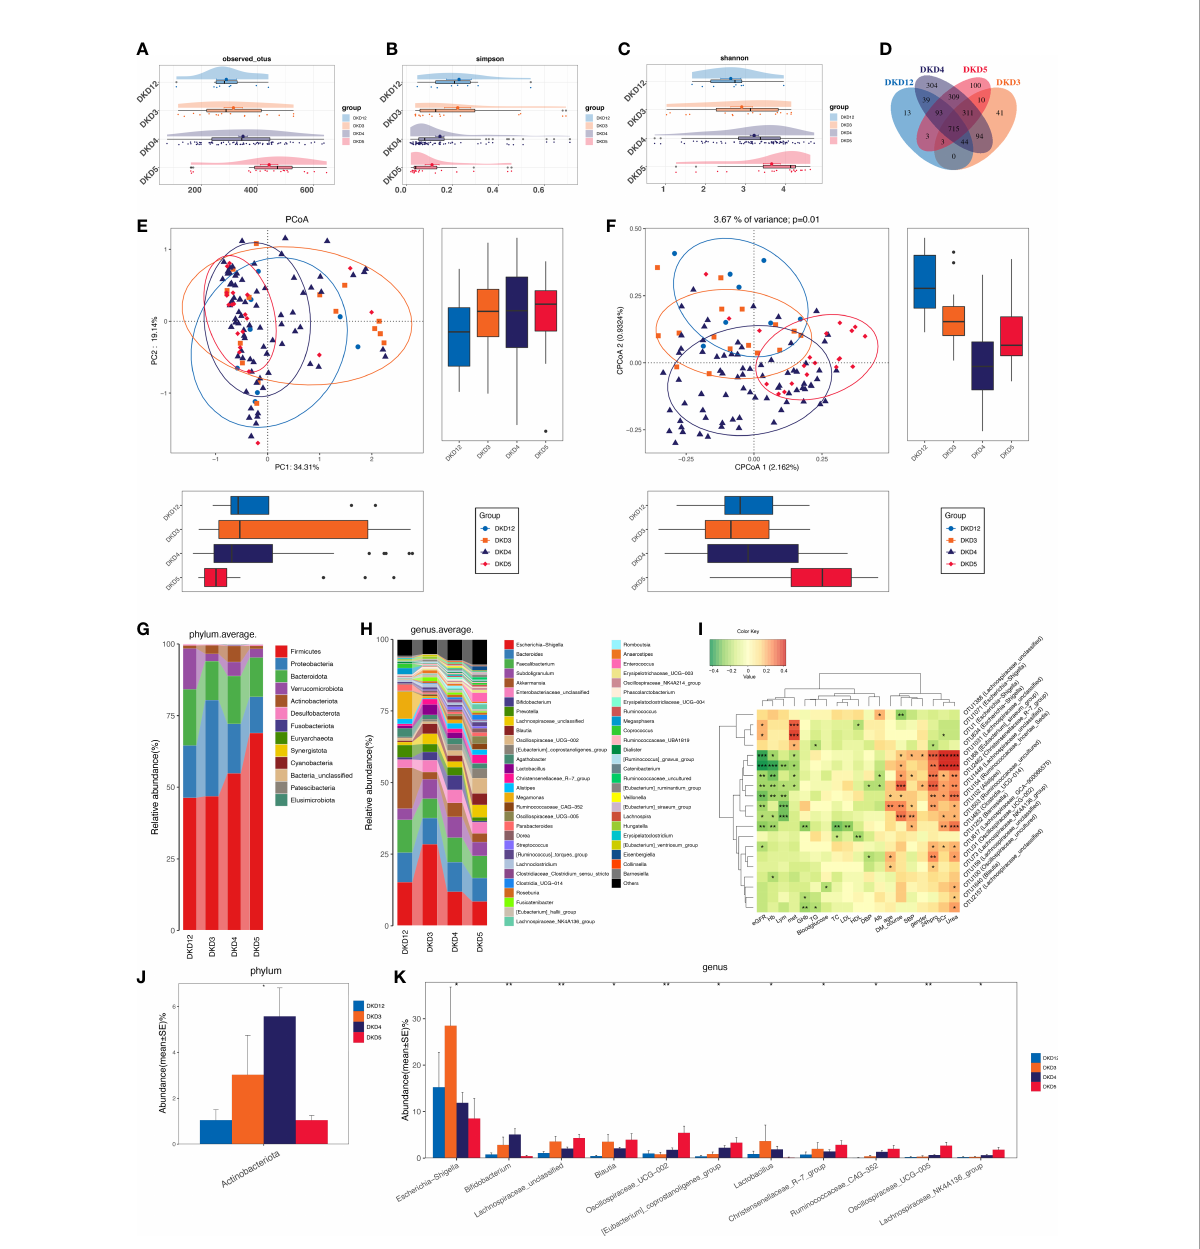
FIGURE 5 Grouping DKD patients (12 DKD 1&2, 26 DKD 3, 112 DKD 4, and 30 DKD 5) based on clinical stages and their analysis of intestinal bacterial diversity and microbial communities ’ alteration during DKD exacerbation and Spearman ’ s correlation analysis between key OTUs and crucial clinical indices. The observed OTUs (A) and Simpson/Shannon indices (B, C) were used to assess a diversity. Venn diagram presented the observed OTUs among four groups (D) . PCoA analysis (E) was measured by Bray – Curtis distance at the I level. CAP analysis (F) was measured by unweighted UniFrac distance. Intestinal microbial composition at the phylum (G) and genus (H) level. Kruskal – Wallis rank-sum test was used to compare and identify signi fi cantly altered bacteria at the phylum (J) or genus (K) level. Only bacteria with gradually increased or decreased abundance between two groups were shown. Spearman ’ s correlation relationship between key altered OTUs and crucial clinical indices were presented as heatmap (I) . PCoA, principal coordinate analysis; PC, principal component, PC1, PC2, and PC3. * p < 0.05, ** p < 0.01, *** p <